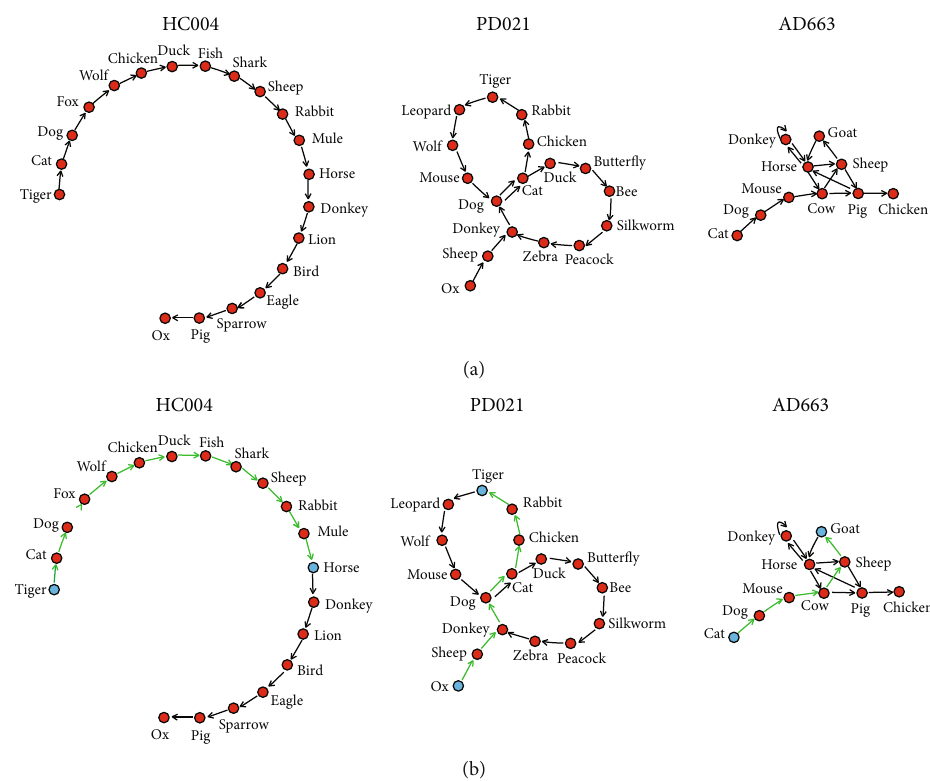
Figure 1: (a) Directed speech graphs of three representative participants. HC004, a healthy control subject; PD021, a patient with Parkinson ’ s disease; AD663, a patient with Alzheimer ’ s disease. (b) Graph geodesic as the shortest path (green) between two nodes (blue) in the three participants. Table 1: Demographic and clinical features, and neuropsychological measures of PD patients and healthy controls (means, standard deviations, and group di ff